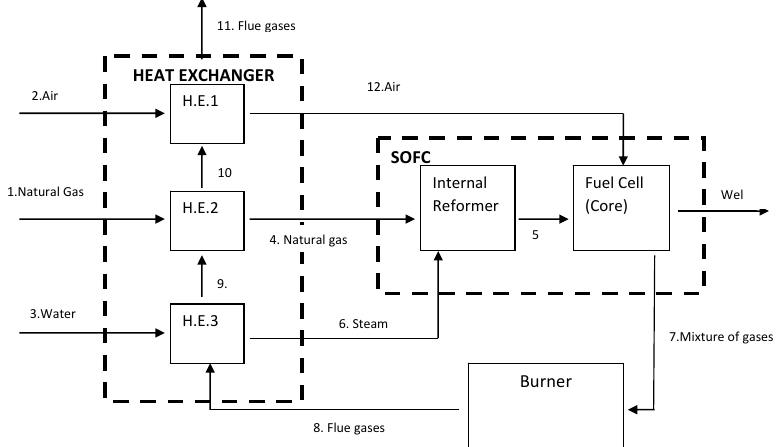
Figure 1. Flow chart of the innovative Solid Oxide Fuel Cell (SOFC) based Electric Vehicles (EV)’s charge station.